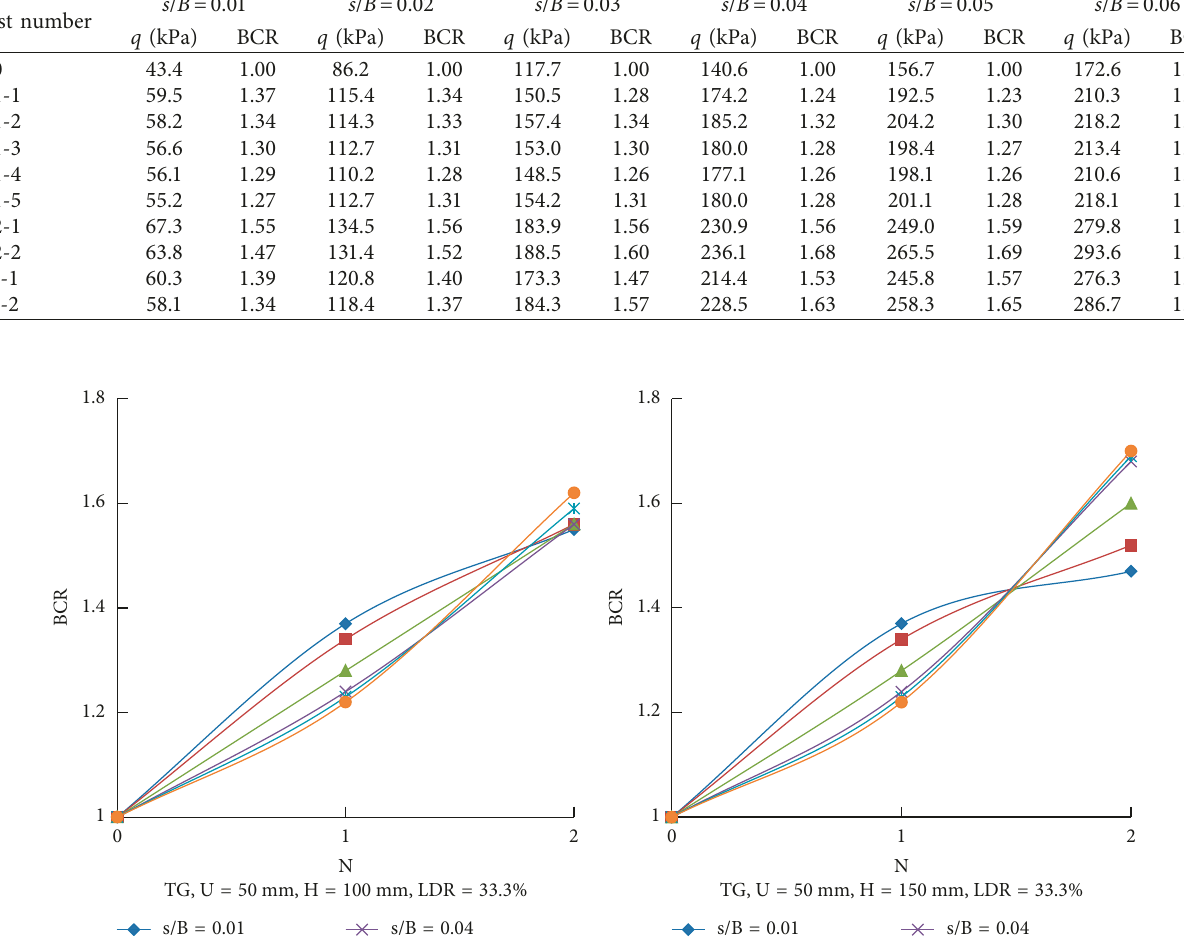
50mm, H 100mm, and LDR (cid:30) (cid:30)